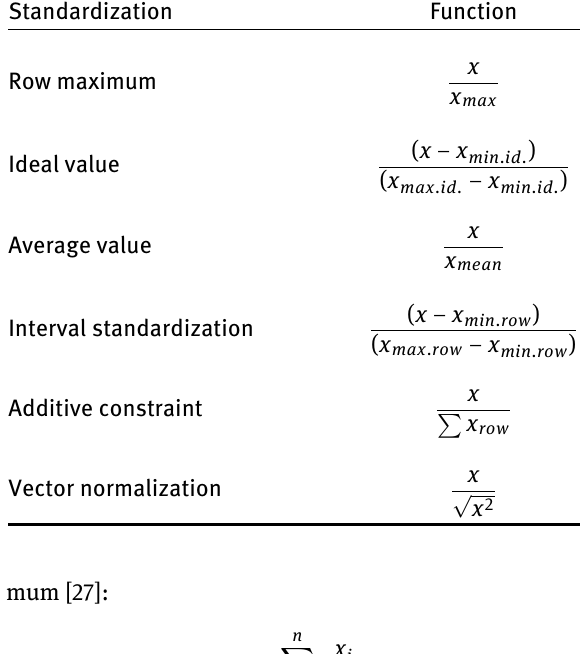
Figure 19: Octopus graph of multiobjective optimization